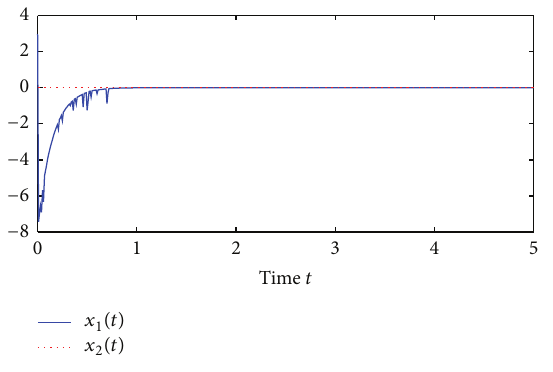
Figure 5: Controller